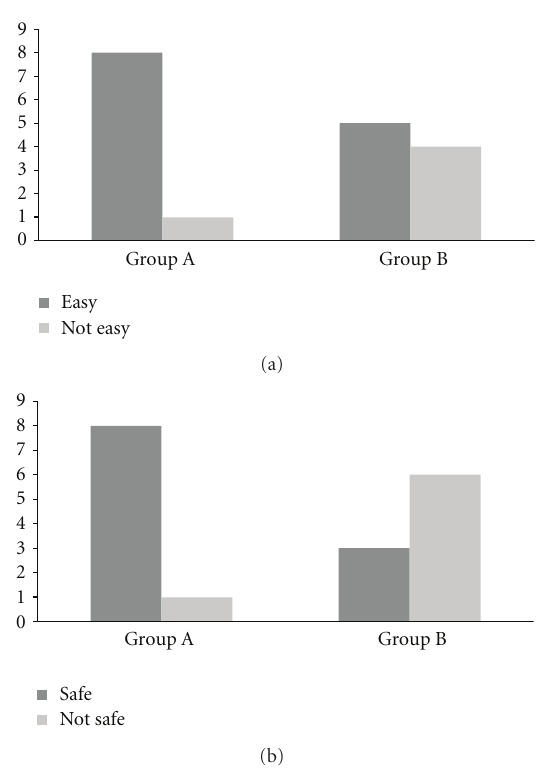
Figure 3: (a) Advanced paramedic trainee response to question- naire regarding ease of use of IN or IV delivery. (b) Advanced paramedic trainee response to questionnaire regarding safety of use of IN or IV